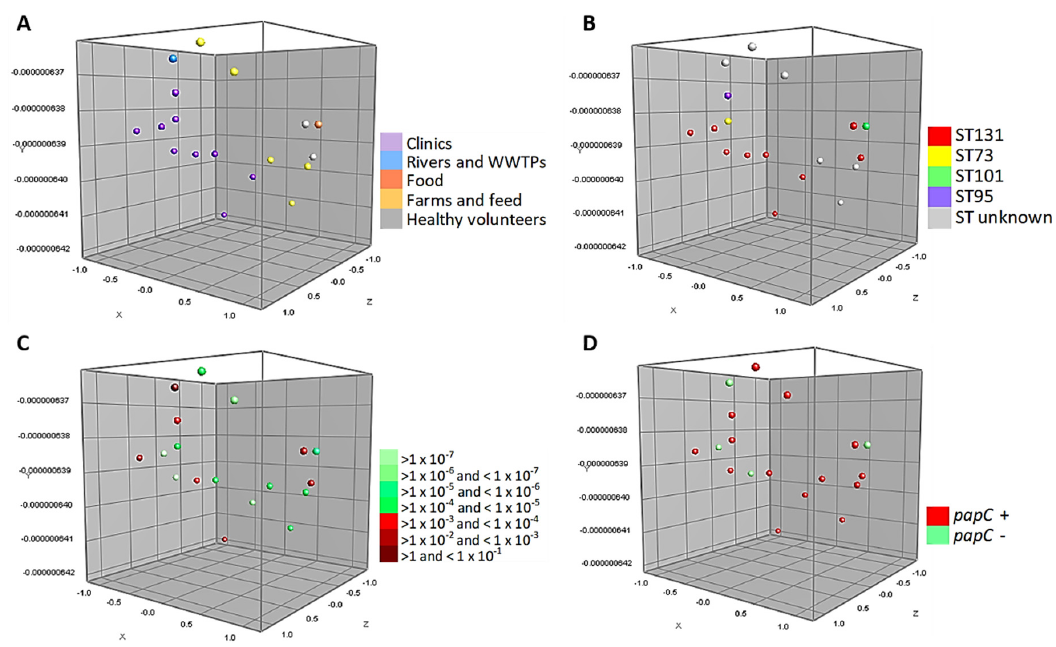
Figure 3. Multidimensional scaling graphs (MDS) for the 18 isolates B2, tested in the conjugation assays; ( A ) According to the distribution by origins; ( B ) MLST types; ( C ) Conjugation frequency ranges of these strains, and ( D ) Prevalence of papC genes.